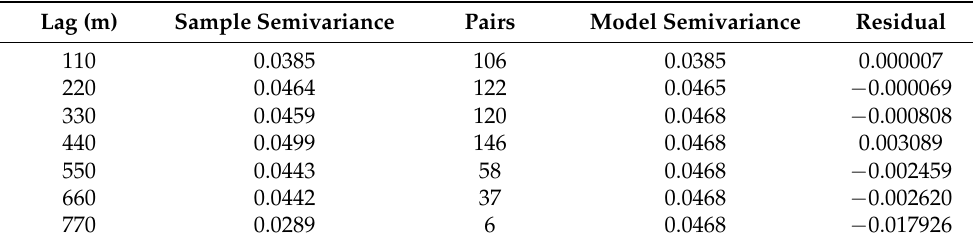
Table 3. Tennant Creek sample and exponential model semivariances.